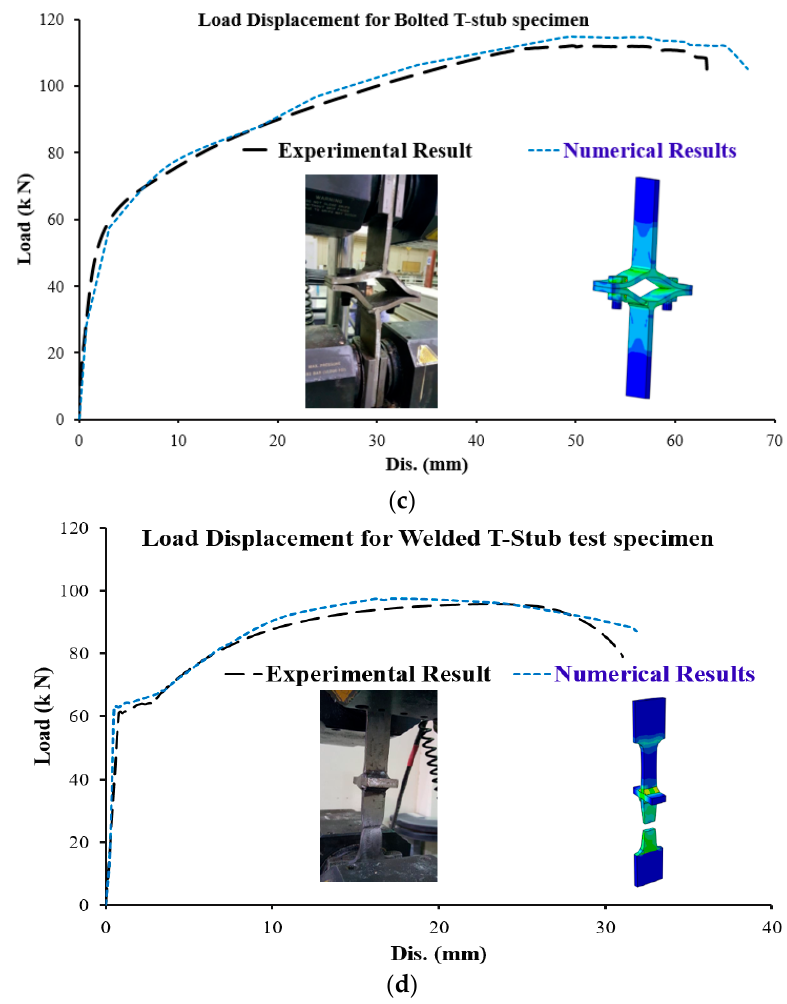
Figure 8. ( a ) Stress strain curves for the column flange coupon steel plate specimen, ( b ) Load versus displacement response for the column flange coupon steel plate specimen, ( c ) Load versus displacement response for the steel bolted T-stub specimen, ( d ) and Load versus displacement response for the steel welded T-stub specimen test.